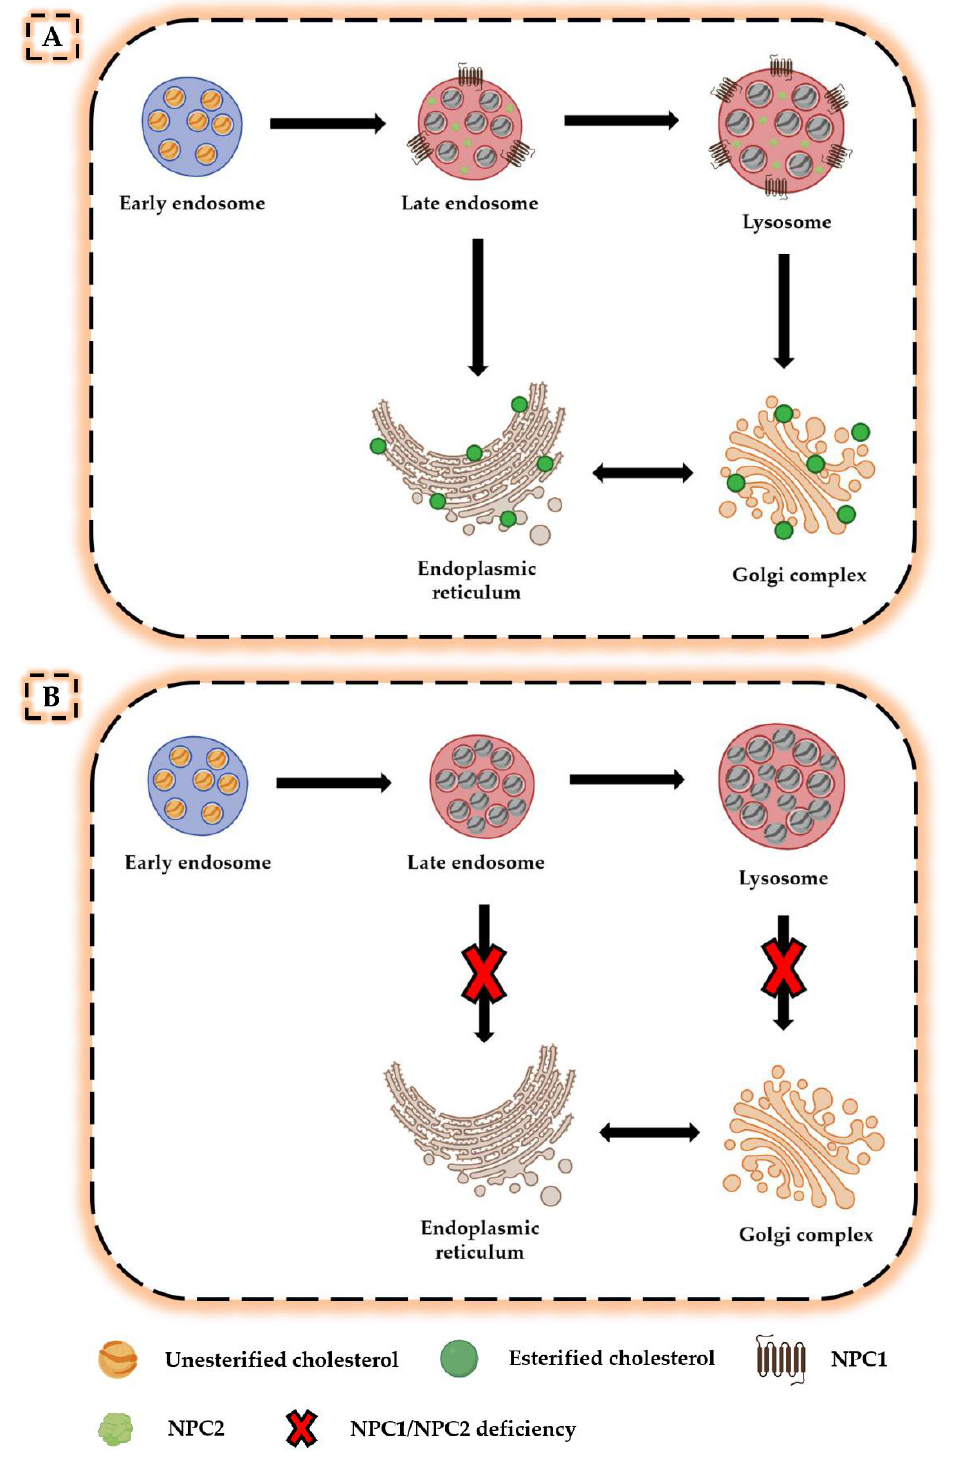
Figure 1. Altered cholesterol trafficking in Niemann–Pick disease type C. ( A ) In normal conditions, lipoprotein cholesterol particles bind to cell surface receptors and are internalized in the late endosome/lysosome system. In the presence of NPC1 and NPC2 proteins, unesterified cholesterol is transported from the late endosomal/lysosomal system to the Golgi complex and endoplasmic reticulum, where it is processed and used for other reactions. ( B ) In the absence of NPC1 or NPC2, unesterified cholesterol accumulates in the late endosomal/lysosomal system, resulting in deficiencies in the intracellular compartments for which it was intended.